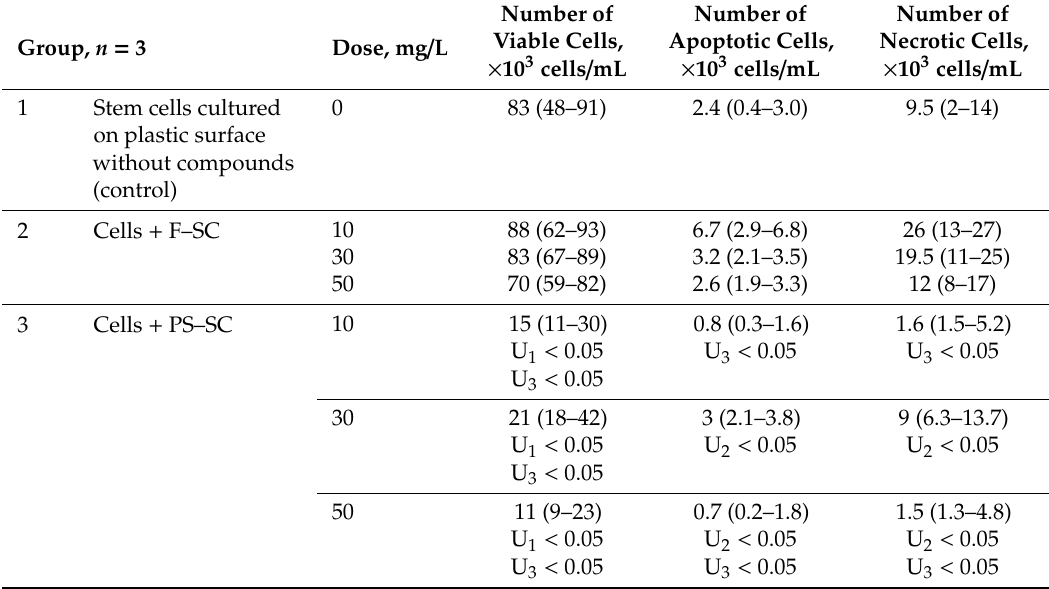
Table 1. The indices of human adipose-derived multipotent mesenchymal stromal cells (hAMMSCs) viability after 21 days of culturing in the presence of tested compounds, Me